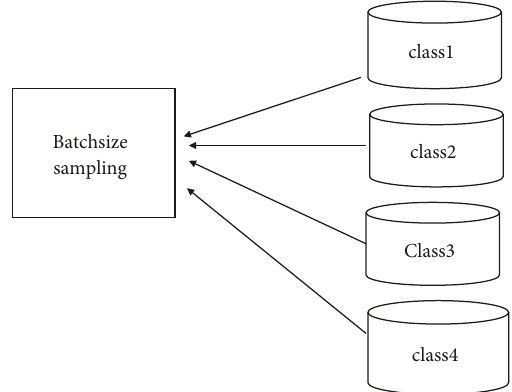
Figure4:Re-samplesfromdifferentsubdatasetsforeverybatch-size